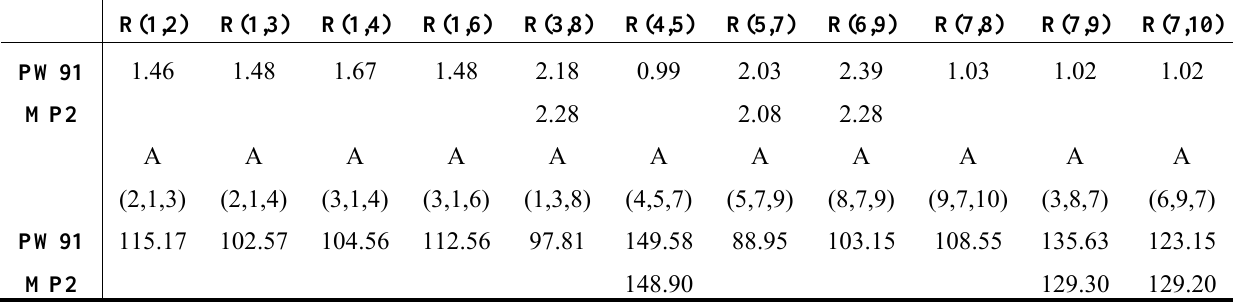
Table 1. Geometrical properties (intermolecular distances R(a,b) and angles A(a,b,c)) of ) obtained at PW91PW91/6-311++G(3df,3pd) (PW91) and MP2/aug-cc- (HSO 4- )(NH 3 pv(D+d)z [22] levels of